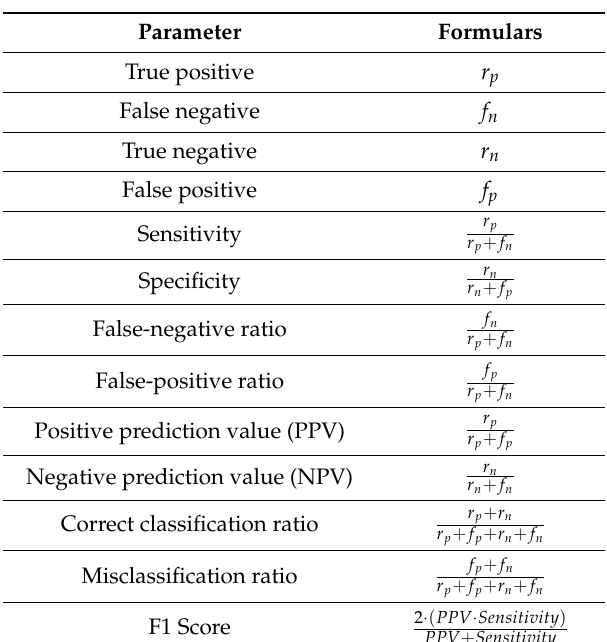
Table 1. Statical-evaluation